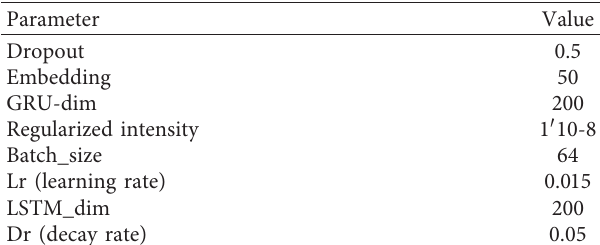
Table 3: Parameter